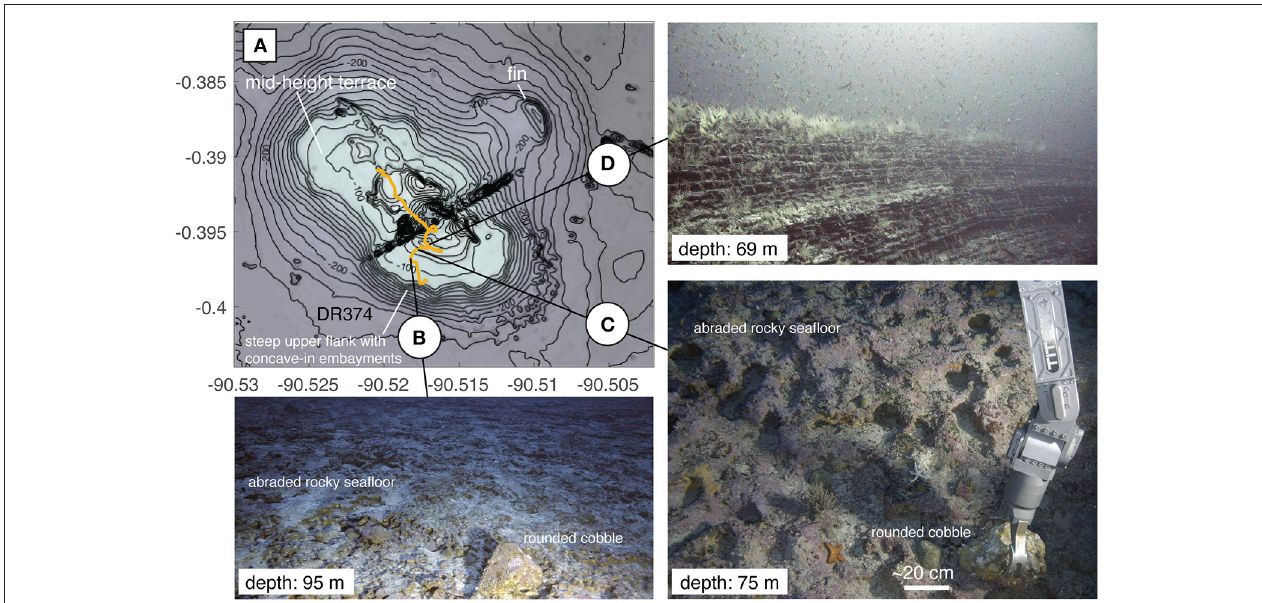
FIGURE 5 | Map and images of DR374 seamount. (A) Bathymetric contour interval is 10m. Gold line shows dive track for seamount DR374. The seamount has steep upper flanks and a broad mid-height terrace that is concentric about the seamount’s summit (i.e., encircles the entire seamount). The contour of the terrace edge is irregular and includes flank embayments giving it a scalloped shape. There are multiple irregular spines and fins protruding from the seamount’s flank and summit. NE-SW striking linear feature near the summit of the seamount is a data artifact. (B) Rounded boulder on smoothed bedrock material constituting the seamount’s terrace. (C) Collection of rounded cobbles and detailed view of smoothed bedrock constituting the seamount’s terrace. (D) Truncated outcrop of thinly bedded volcaniclastic material near the seamount’s summit. Depths in photos indicate the depth of the seafloor at the point of image capture.